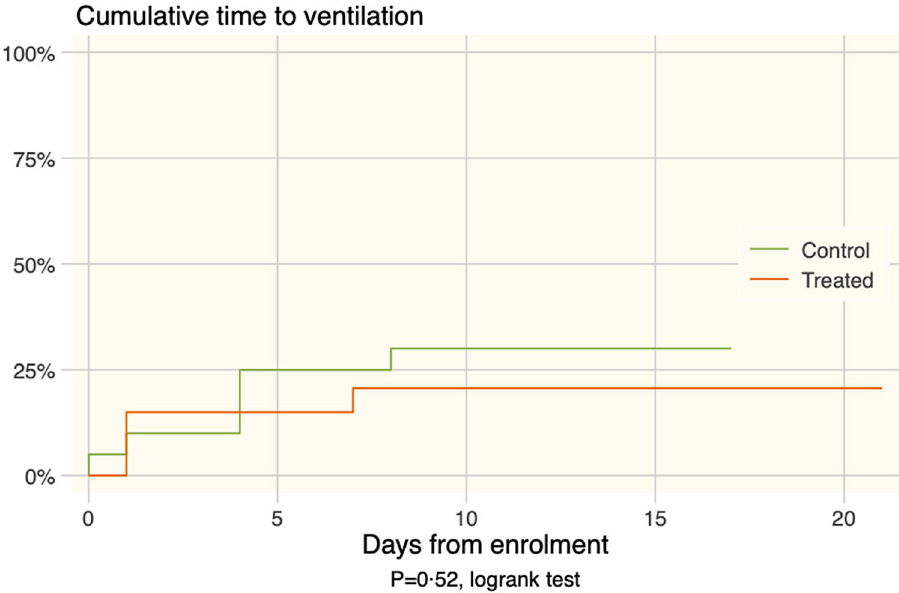
Figure 2. The plot shows cumulative ventilation rates for each